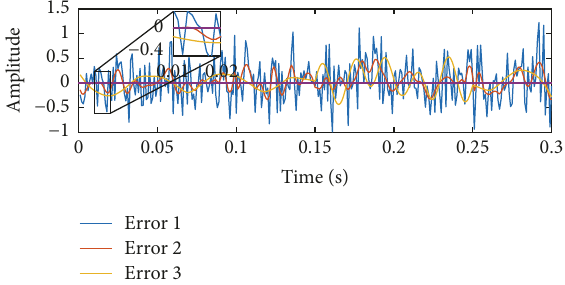
Figure 7: Denoising error line with wavelet and